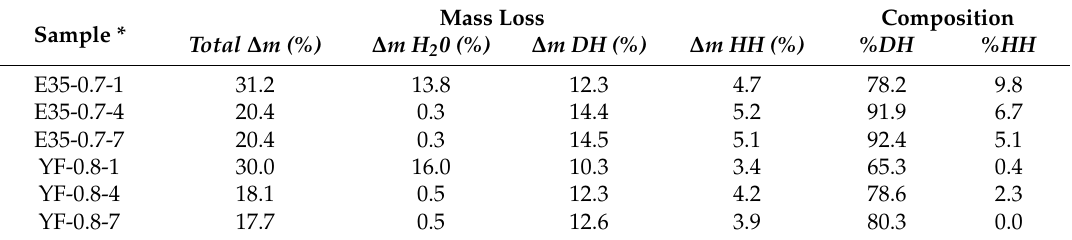
Table 3. Results of the thermogravimetric analysis for samples YF-0.8 and